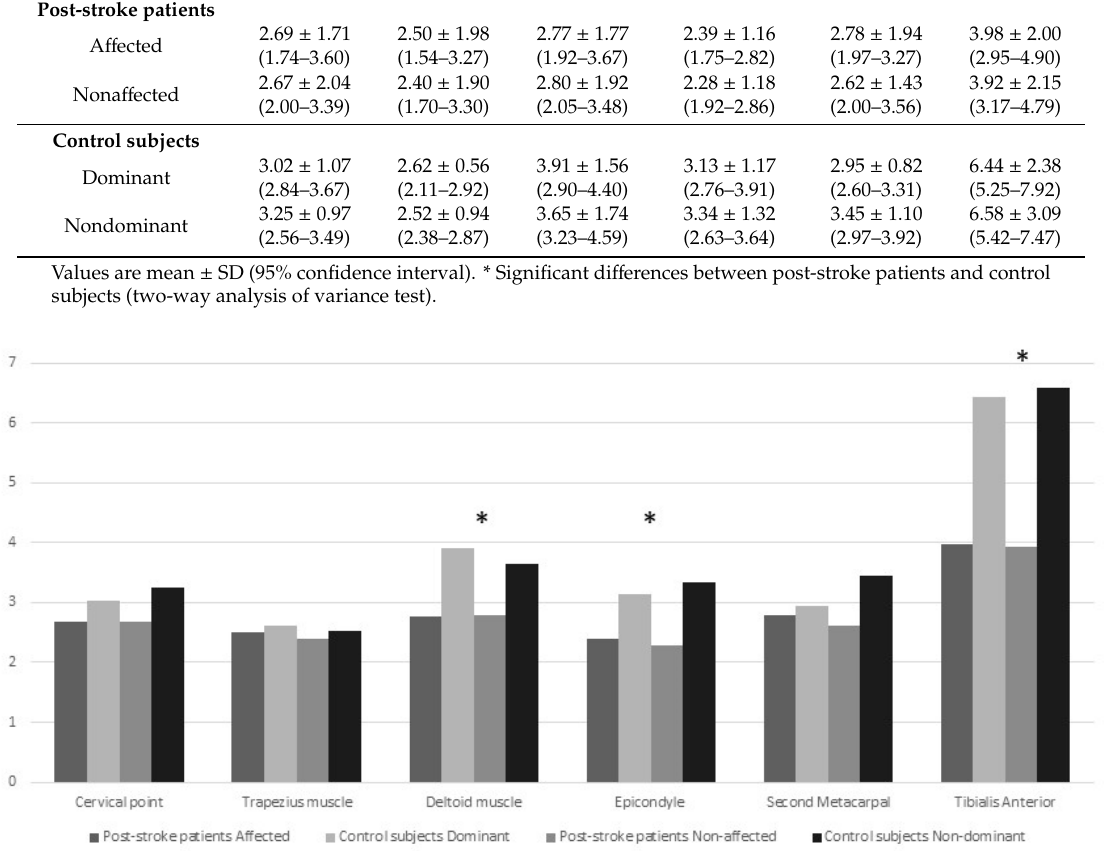
Figure 1. Representation of pressure pain threshold levels (kg / cm 2 ) in post-stroke patients and healthy controls on each point. * Significant differences between post-stroke patients and control subjects.